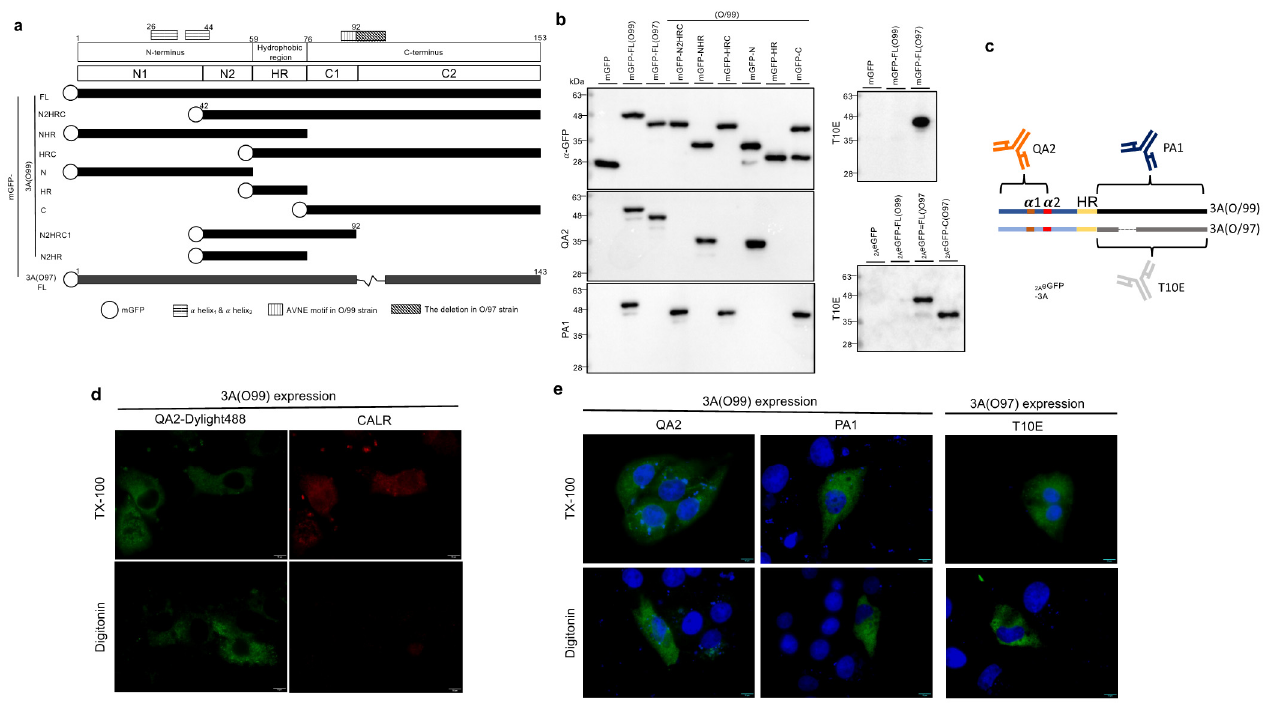
Figure 1. ( a ) Diagram representing the different truncations of O/99 3A or O/97 3A fused with monomeric GFP (mGFP). We set the alpha-helix2 region and the deletion region in O/97 as the turning points to separate the N- and C-termini into N1/N2 and C1/C2. All the truncation forms here used the O/99 normal virus strain as a template, including the aa 1–41 deletion (mGFP-N2HRC), aa 1–41 and aa 93–153 deletion (mGFP-N2HRC1), N-terminus deletion (mGFP-HRC), C-terminus deletion (mGFP-NHR), hydrophobic region (mGFP-HR), C-terminus (mGFP-C), and N-terminus (mGFP-N). ( b ) The constructs, expressed in PK-15 cells, were used to examine homemade anti-3A MAbs by Western blotting. QA2 could not recognize N2HRC, indicating the binding site located at the region within aa 1–41 of 3A, while PA1 recognized the C-terminus of 3A from O/99. The binding site for T10E should be the C-terminus of O/97 3A. ( 2A eGFP: eGFP fused with FMDV 2A peptide in N-terminus.) ( c ) The schematic of the MAb binding sites on 3A protein. ( d ) PK15 cells were transfected for expressing 3A from O/99 or O/97. After fixation, the cells were permeabilized using Triton X-100 or digitonin. Anti-calreticulin rabbit antibodies were used to stain the cells in the control group, followed by anti-rabbit secondary antibodies (red) and MAb QA2 conjugated to Dylight 488 (green) for dual labelling. ( e ) For the examination of the topology of 3A, the cells were stained with the indicated MAb (QA2, PA1, or T10E), followed by anti-mouse secondary antibodies. The nucleus was stained using Hoechst stain.